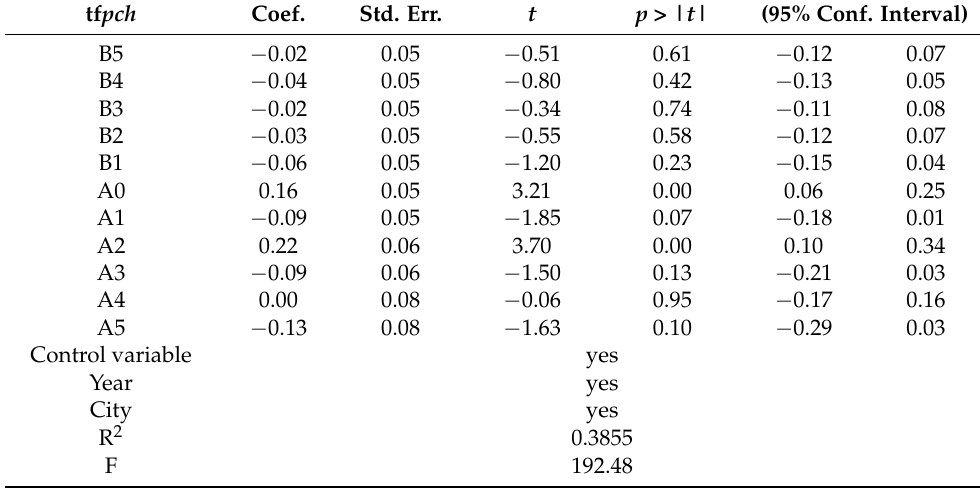
Table 4. Parallel trend test.